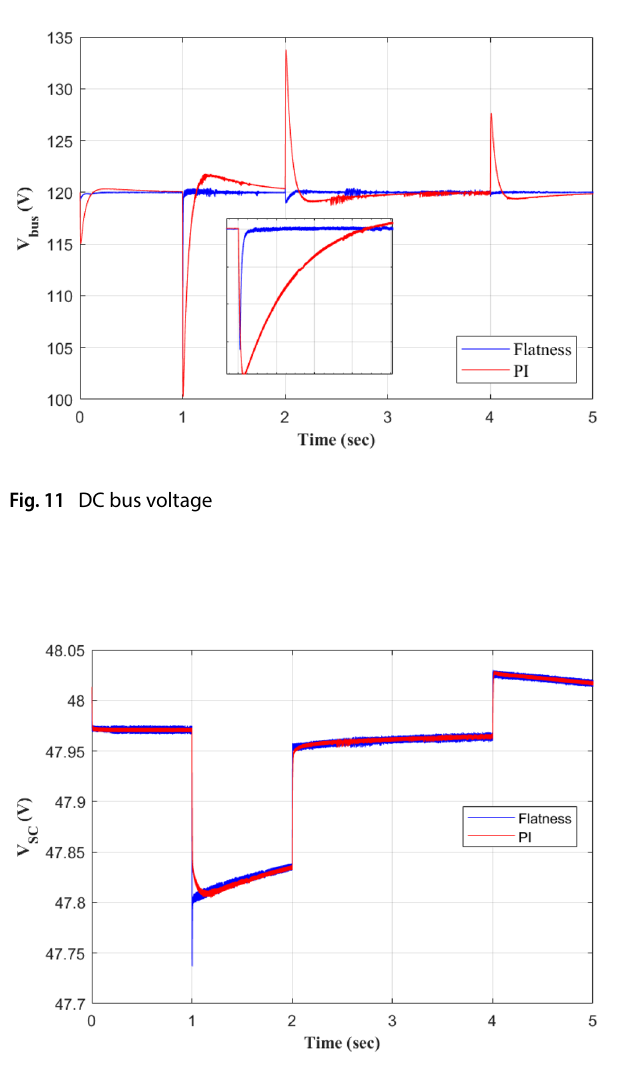
Fig. 12 SC power using both technics PI and